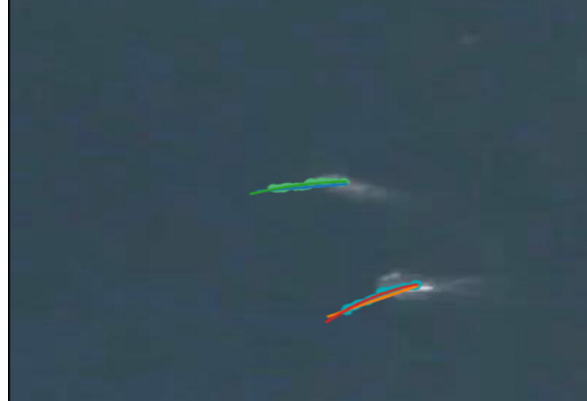
Figure 6. The Precision-Recall curve of the multi-frame YOLOv3 model. Figure 7. Visualization result of movement prediction. The blue and orange curves represent the real motion trajectories of the two targets. The green and red curves represent the prediction trajectories of the respective targets. The marked center points on the curves are the detection